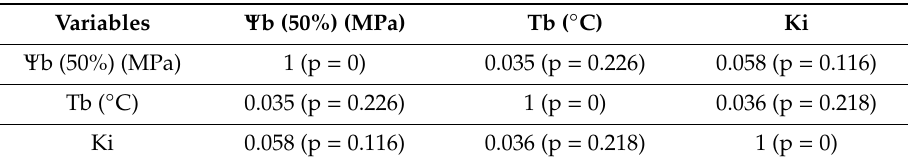
Table 2. Correlation between Ψ b, Tb and Ki (R 2 ).